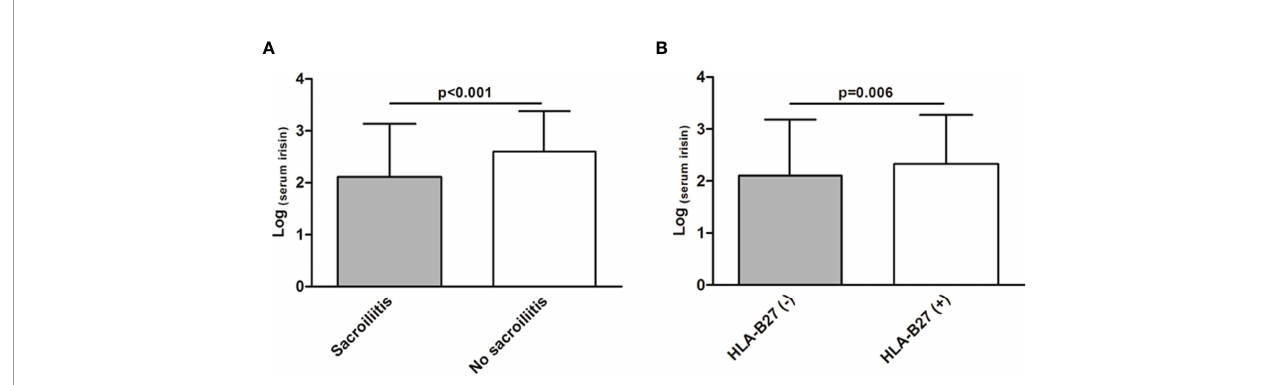
FIGURE 2 | Association between serum irisin levels and axSpA-related features. Lower serum levels of irisin in patients with sacroiliitis (A) and in patients with a negative human leukocyte antigen (HLA)-B27 status (B) . Results shown in (A) and (B) were obtained after linear regression analysis, adjusting for sex, age at the time of the study and classical cardiovascular risk factors.